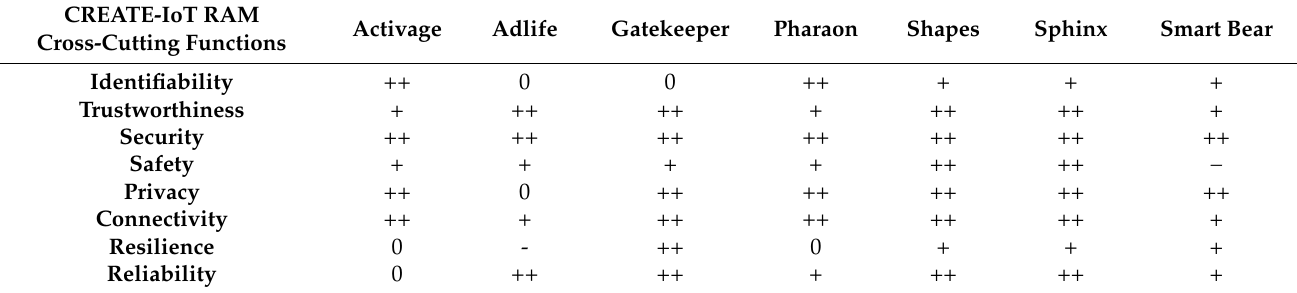
Table 5. Projects’ architectures addressing CREATE-IoT 3D RAM cross-cutting functions. CREATE-IoT